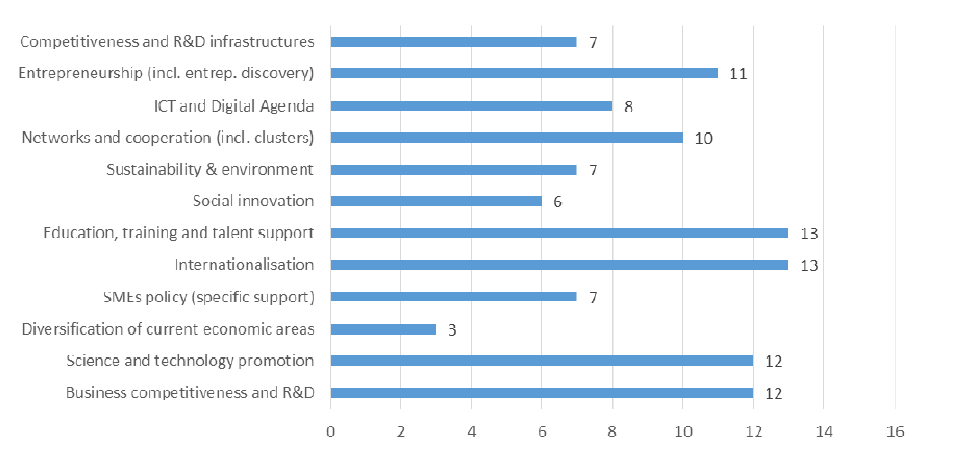
Figure 2: Number of regions in Spain by Type of Policy Area Included in the